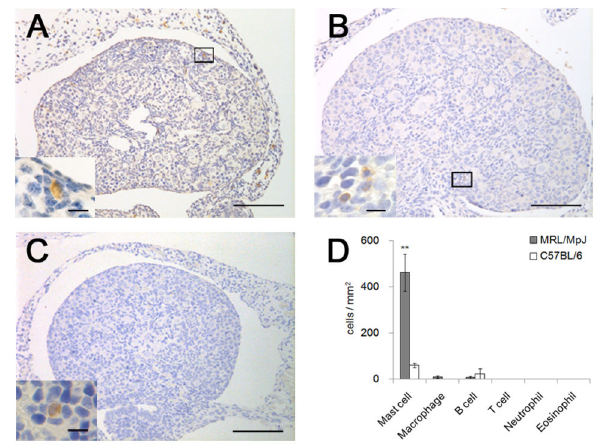
Figure 2. The appearance of immune cells in the ovaries of neonatal mice. (A–C) The ovaries of MRL/MpJ mice at postnatal day 0. Immunohistochemical analysis of F4/80 (macrophage marker, panel A), B220 (B cell marker, panel B), and CD3 (T cell marker, panel C). A few F4/80- and B220- positive cells (panels A and B), but no CD3-positive cells (panel Figure 3. Strain differences in the appearance of ovarian C), are observed in the ovaries of the MRL/MpJ mice. The mast cells in neonatal mice. (A) Ovarian mast cell (MC) insets show a higher magnification of the boxed area in panels density among 11 mouse strains at postnatal day 0. The A and B. In panel C, the inset shows the spleen section at number of metachromatic MCs in the whole area of the ovary postnatal day 0 as a positive control. Bars in panels: 100 µm. (gray bars) or in the surface epithelial region of the ovary (white Bars in insets: 10 µm. (D) Number of immune cells in the bars) was divided by the area of the ovary. Data represent the ovaries at postnatal day 0. Data represent the mean ± SEM (n mean ± SEM (n = 4–8 in each group). Significant differences = 3–6 in each group). Significant differences were analyzed were analyzed using Scheffé’s method subsequent to the using the Mann-Whitney U test. **: P < 0.01. Kruskal-Wallis test. *: P < 0.05, **: P < 0.01 vs. MRL mice. †: P < 0.05, ‡: P < 0.01 vs. DBA/1 mice. (B and C) Toluidine blue- stained ovary sections of neonatal mice. Only a few ovarian MCs are present in CBA mice (panel B, arrows). BALB/c mice Table 2. Mast cell density in various organs at postnatal have metachromatic MCs mainly at the border between the day 0. cortex and medulla of the ovary (panel C, arrows). Bars: 100 Ovary/ Liver Kidney Heart Spleen Skin Testis 0.7 ± Female MRL/MpJ 0.1 0.3 ± C57BL/6 0.1 1.1 ± Male MRL/MpJ 0.3* 0.2 ± C57BL/6 0.2 Units: number of mast cells/mm 2 . Data, shown as the mean ± SEM (n = 4–6 in